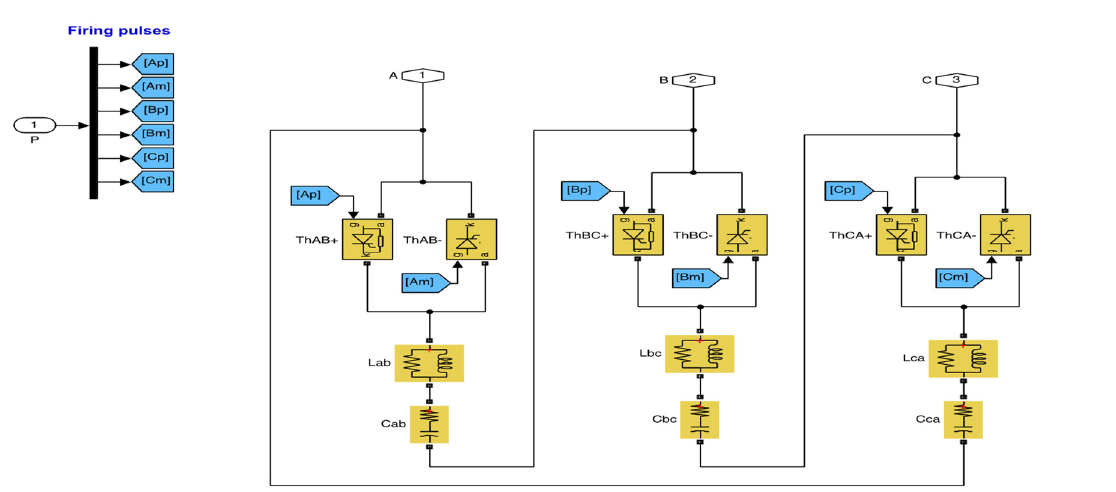
FIG 1: THYRISTOR SWITCHED